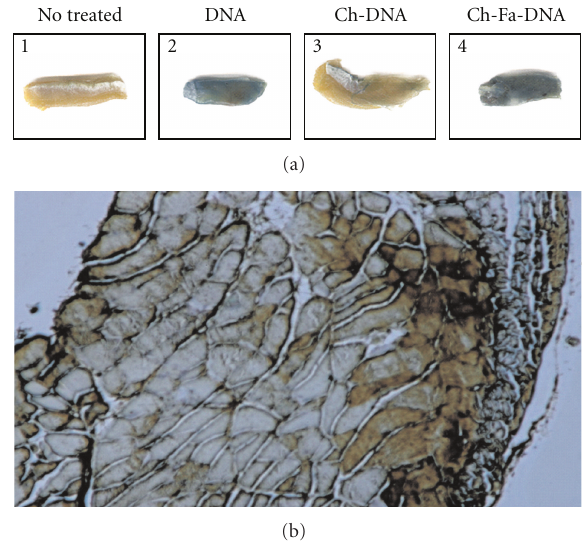
Figure 3: β -gal staining with X-Gal substrate in soleus muscle. Four groups (each consisted of 3 rats) of the normal Lewis rats treated with the hydrodynamic femoral intravenous injection of saline or 200 μ g naked β -gal plasmid, Ch- β -gal plasmid DNA, and Ch-Fa- β -gal plasmid DNA, respectively. Soleus muscle were isolated and visualized for β -gal gene expression with X-gal substrate incubation 3 days post injection. (a) Shows the scanned images from the rat soleus muscles. (1) nontreated controls, (2) naked plasmid β -gal DNA injected, (3) Ch-plasmid β -gal DNA nanoparticles injected, and (4) the Ch-Fa-plasmid β -gal DNA nanoparticles injected rats. (b) Shows soleus muscle histological cross-sectional patterns of β -galactosidase protein expression stained with its corresponding antibody after hydrodynamic Ch-Fa- plasmid β -gal DNA injection (dark brown